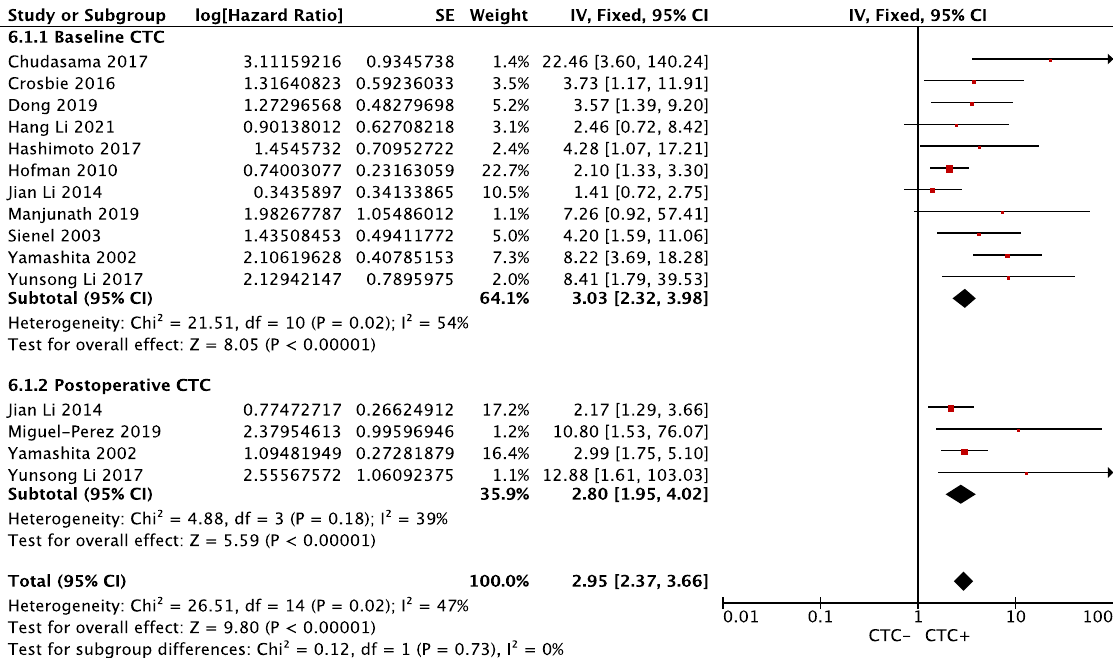
Figure 2. Effect of baseline or postoperative CTC on overall survival in resectable NSCLC. Hazard ratios with 95% confidence intervals are displayed by individual studies, describing pooled overall effects for baseline CTC and postoperative CTC, respectively. Abbreviations: HR, hazard ratio; SE, standard error; CI, confidence interval.